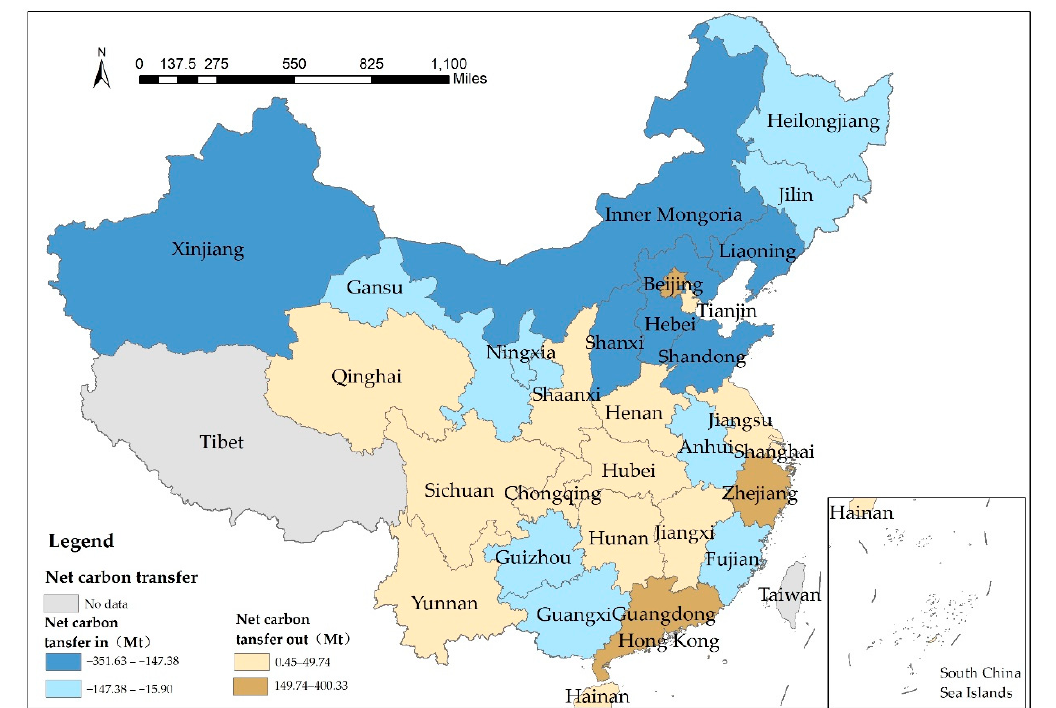
Figure 3. Spatial distribution of net carbon transfer by region in